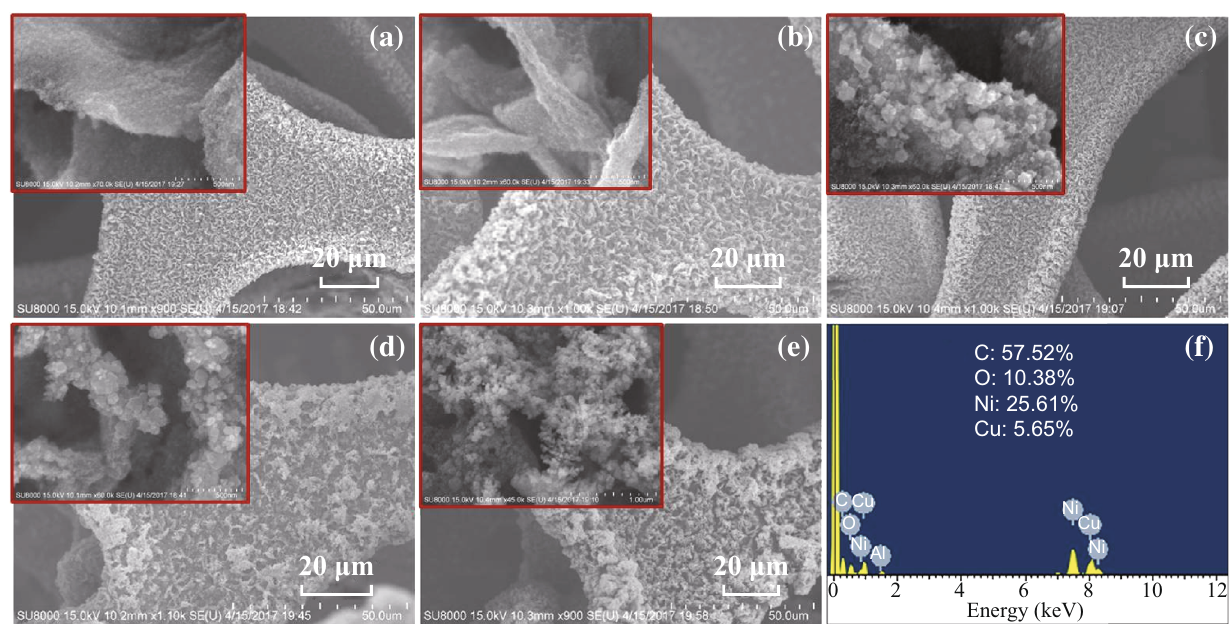
Fig. 2 SEM images of CuNi/C electrodes prepared with different Cu depositing times: a 5 s, b 10 s, c 20 s, d 50 s, and e 100 s. The insets show the corresponding high-resolution images, and f EDS pattern on c